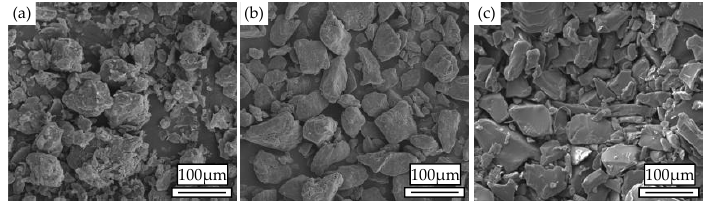
Figure 1. Morphologies of the powder particles: ( a ) walnut shell powder (WSP); ( b ) copolyester (Co-PES) powder; ( c ) copolyamide (Co-PA) powder.